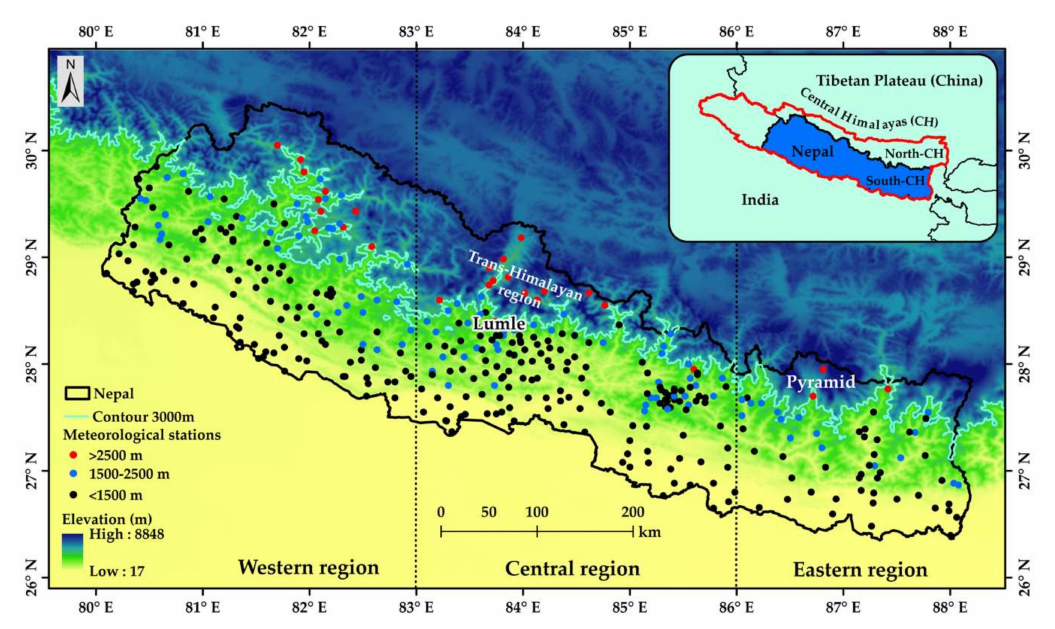
Figure 1. The study region, Nepal is divided into three di ff erent regions and the meteorological stations used are distributed from 60 m above sea level (masl) to 5050 masl. The extent of central Himalayas is adapted from Nie et al.